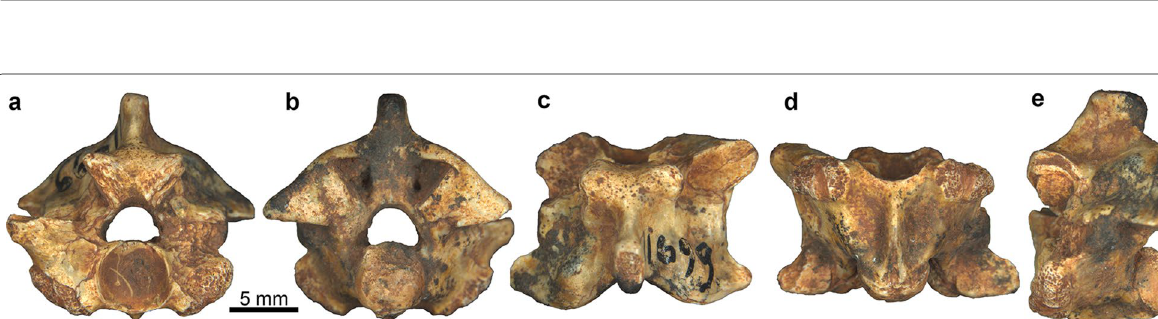
Fig. 12 Palaeopython cadurcensis from imprecisely known locality near Mouillac, Phosphorites du Quercy: mid-trunk vertebra (YPM-VPPU 29855) in anterior ( a ), posterior ( b ), dorsal ( c ), ventral ( d ), and left lateral ( e )